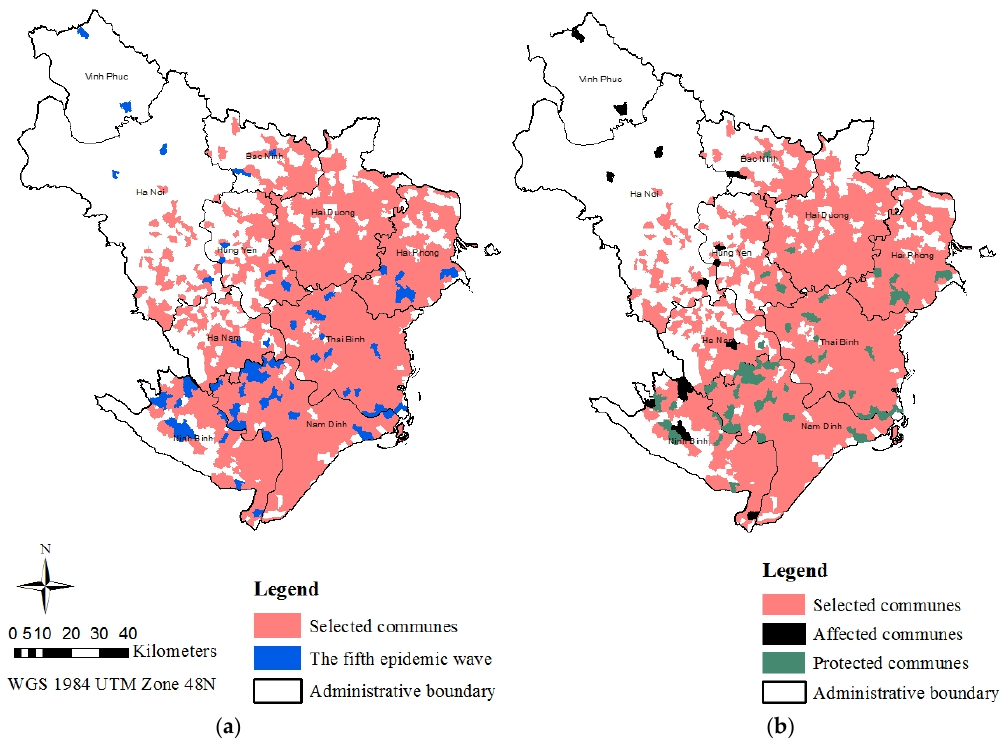
Figure 4. ( a ) Spatial distribution of the fifth epidemic wave in the Red River Delta and the focus areas for the alternative vaccination program; and ( b ) spatial distribution of the estimated affected communes and protected communes under the alternative vaccination program.